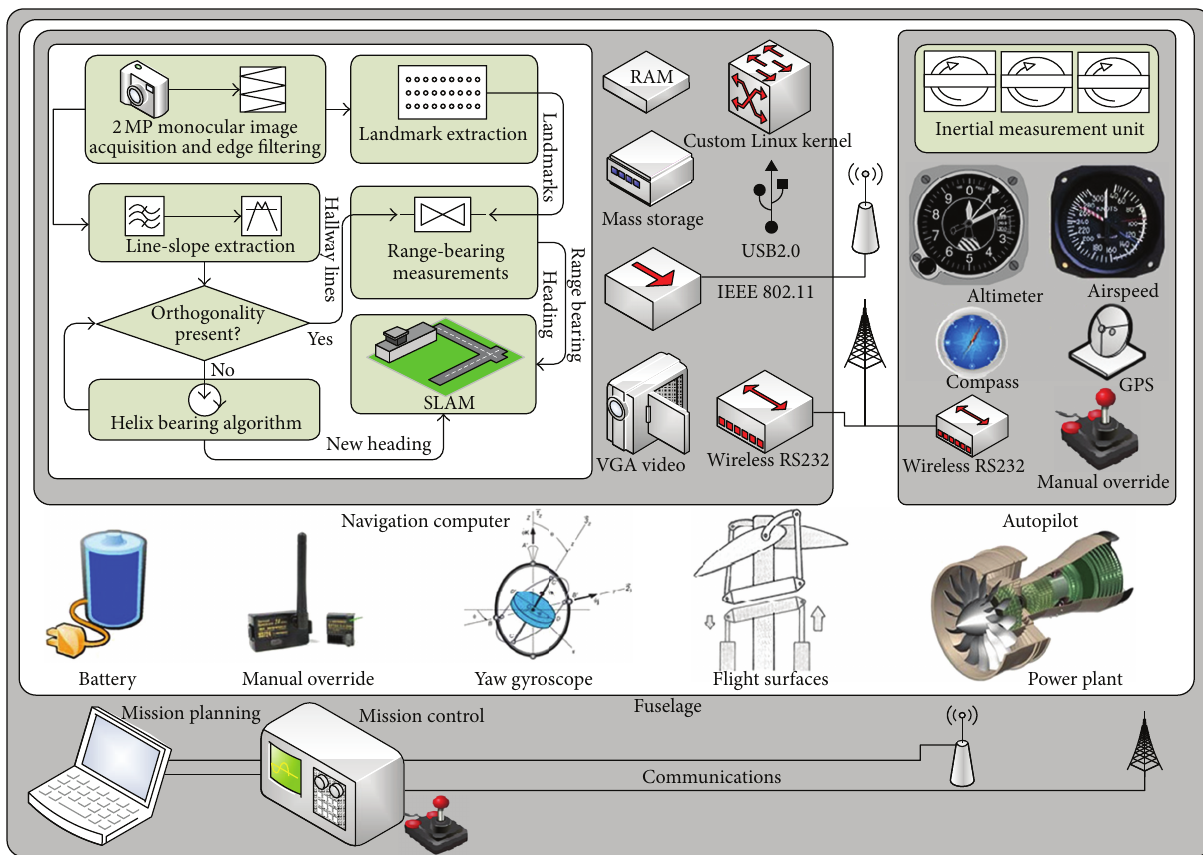
Figure 2: Block diagram illustrating the operational steps of the monocular vision navigation and ranging at high level, and its relations with the flight systems. The scheme is directly applicable to other mobile